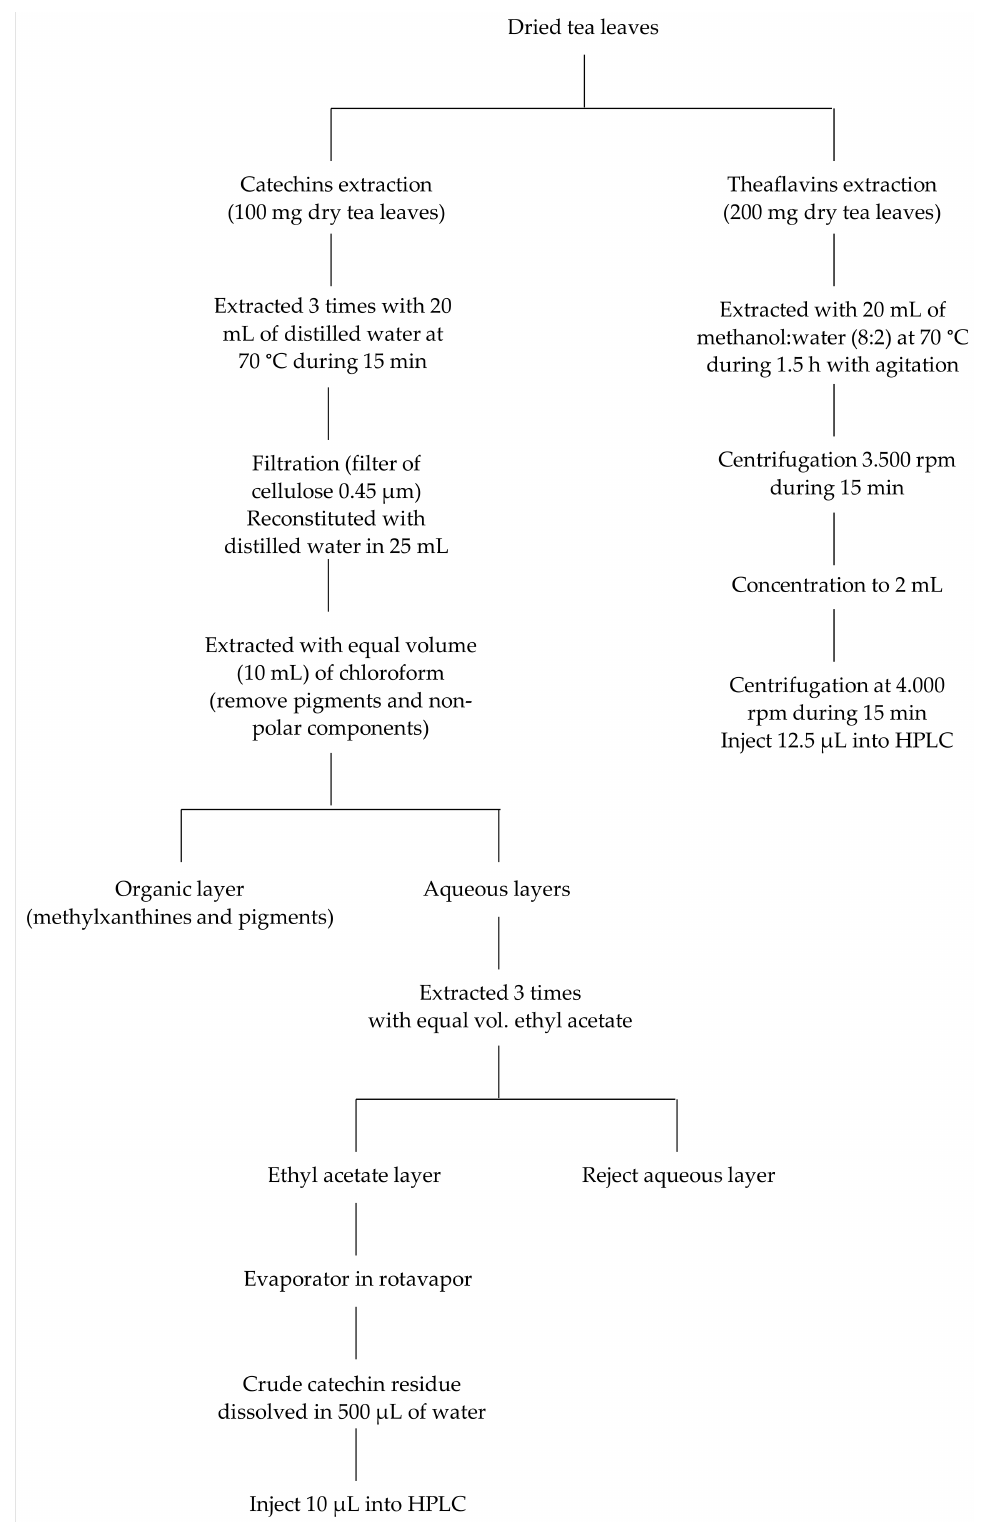
Figure 2. Extraction of catechins and theaflavins from Azorean black tea